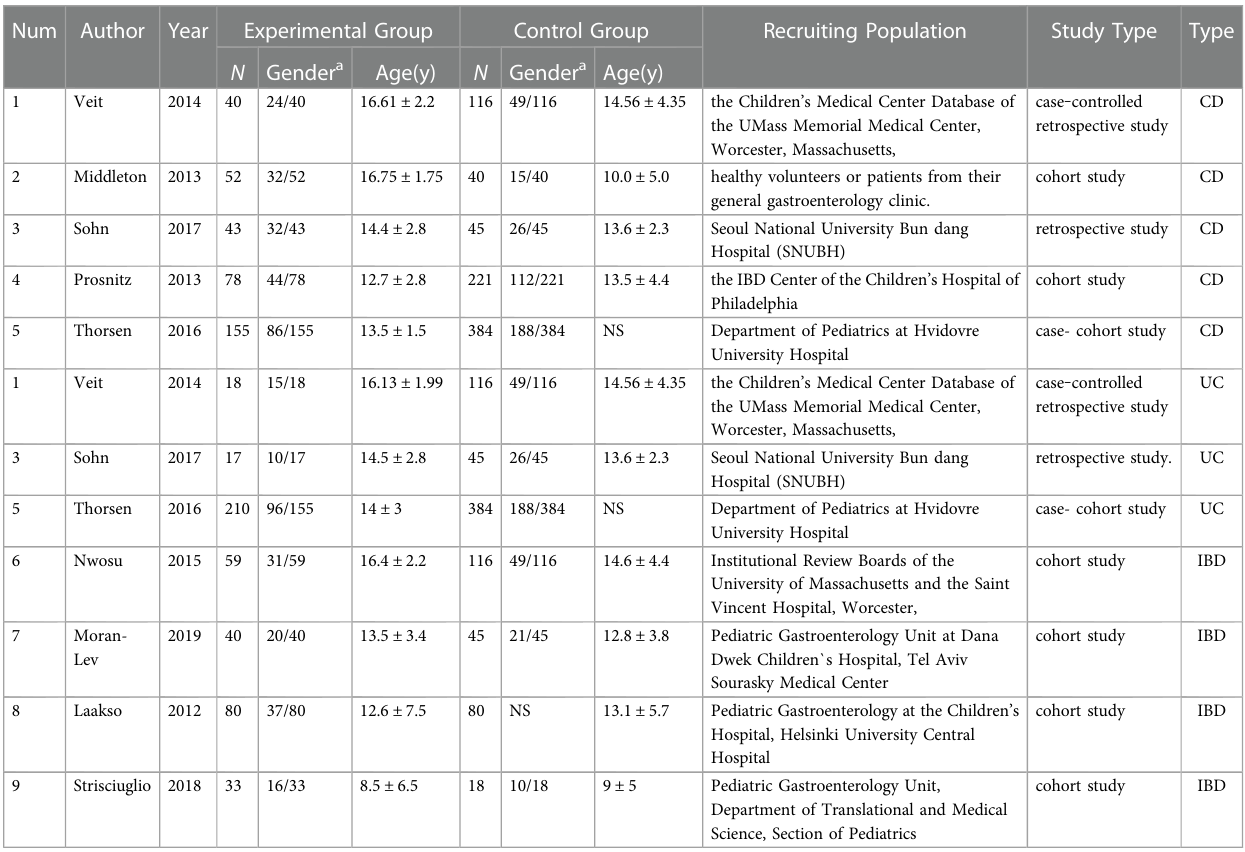
TABLE 1.1 Speci fi c information on the 9 studies on vitamin D levels in IBD patients and healthy controls.